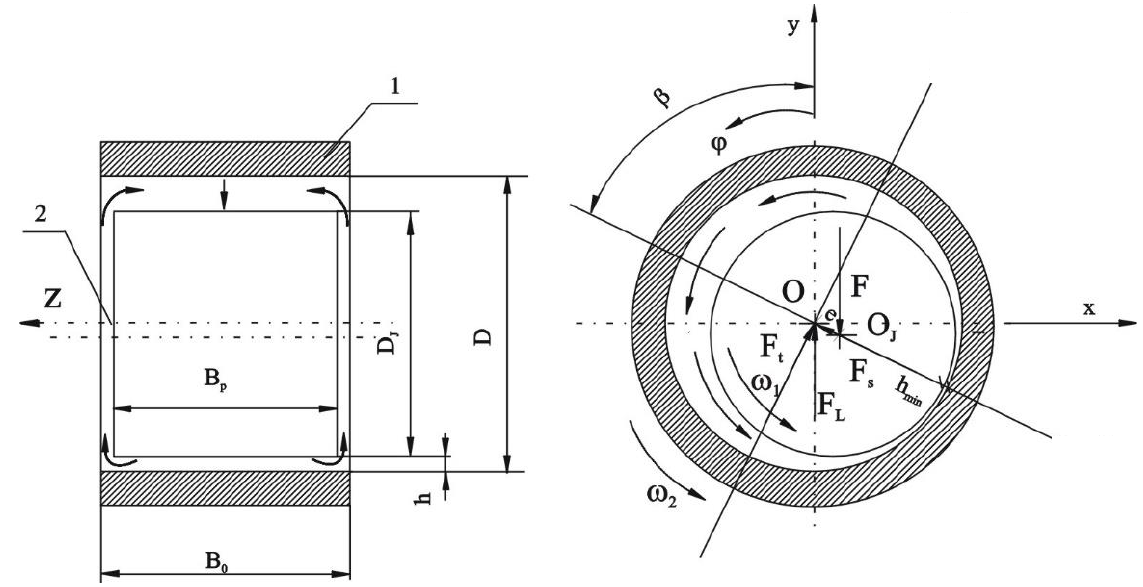
Figure 12. The model including basic geometry, kinematics, oil flow directions and forces in the torsional vibration damper; 1—housing, 2—inertia ring, D —internal diameter of the housing, D J —outer diameter of the ring, B 0 —width of the housing, B p —width of the ring, h —oil film thickness, x,y,z —axes of Cartesian coordinate system, ϕ —angular coordinate, ω 1 —angular velocity of the ring, ω 2 —angular velocity of the housing, O —center of the housing, O J —center of the ring, F —ring weight, F L —the force of hydrodynamic buoyancy with its component forces—normal ( F t ) and tangential ( F s ), h min —minimal oil film thickness, e —ring and housing position eccentricity, β —inclination angle of the center line of the inertia ring ( O J ) and the housing ( O ).